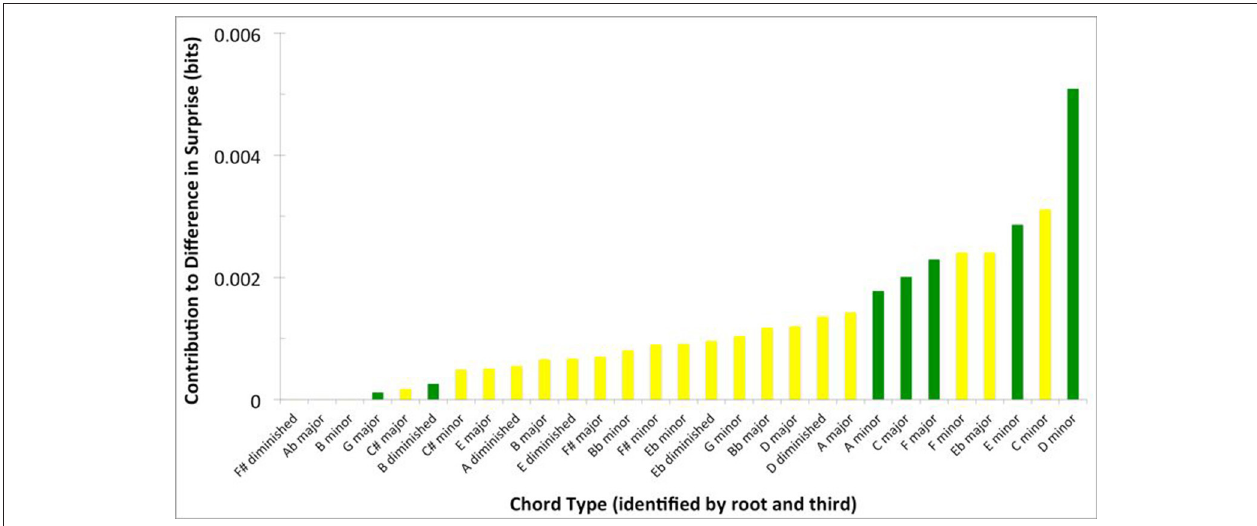
FIGURE 5 | Contribution of chords featured in Q1 songs and grouped by “root and third” to the surprise difference between Q1 and Q4. Chords are organized from smallest to largest contribution. Green bars reflect diatonic chords, while yellow bars reflect chromatic chords. Note that diatonic chords contribute significantly to the difference in surprise between Q1 and